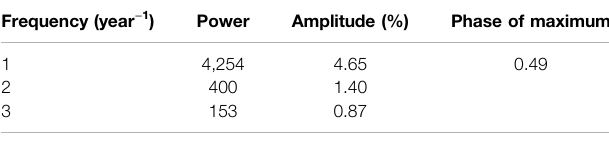
TABLE 3 | The annual oscillation and the leading two harmonics as derived from the GSI noon-centered measurements. Table adobted from [28].